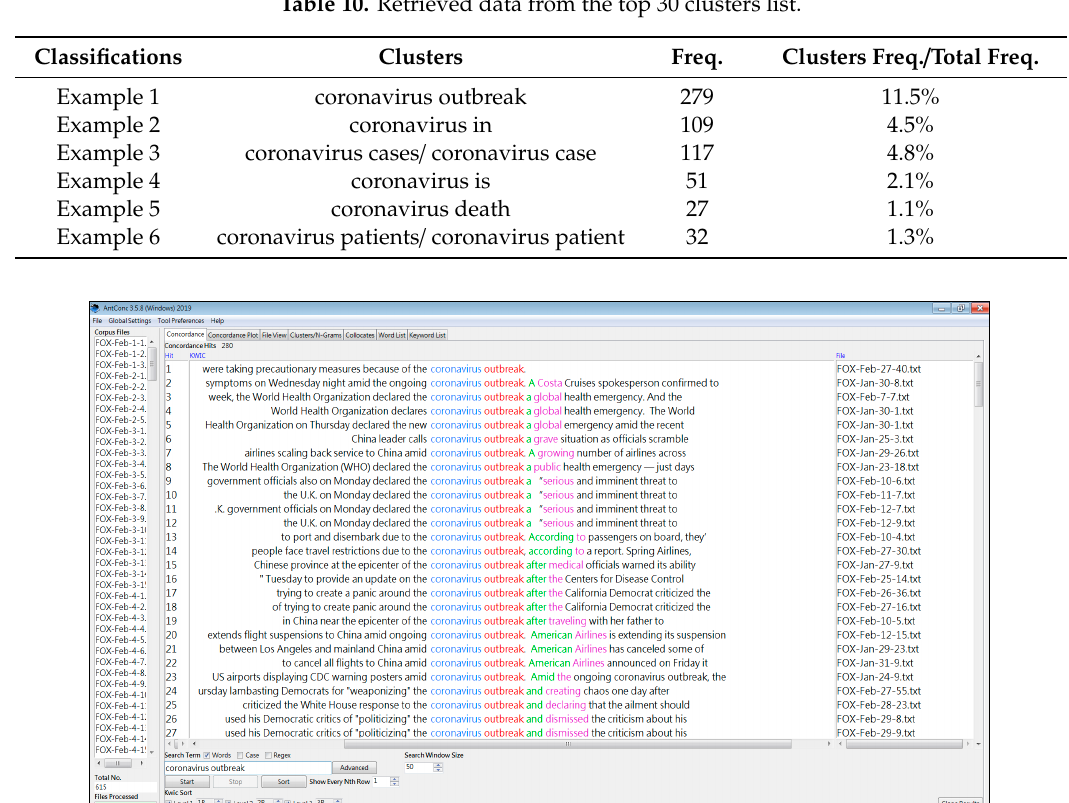
Figure 6. Illustrative examples of concordance lines of coronavirus outbreak from AntConc 3.5.8.